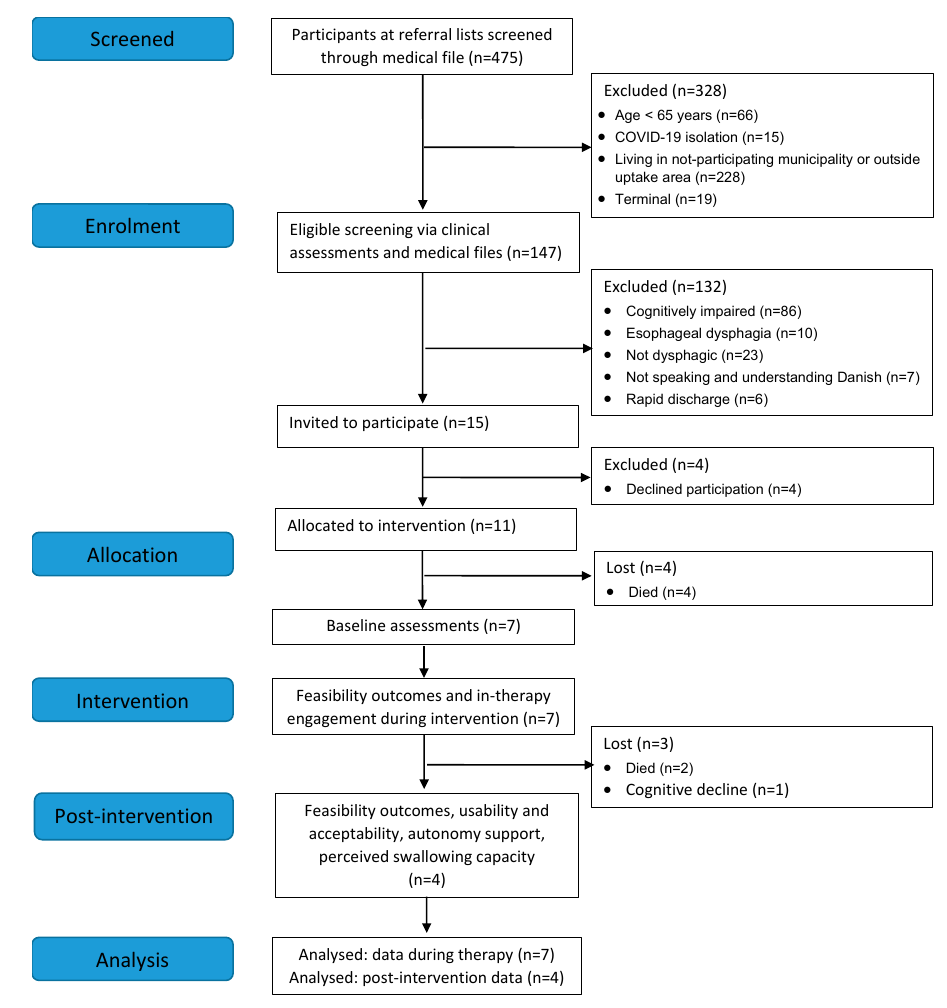
Figure 1. Flow diagram for study participants.